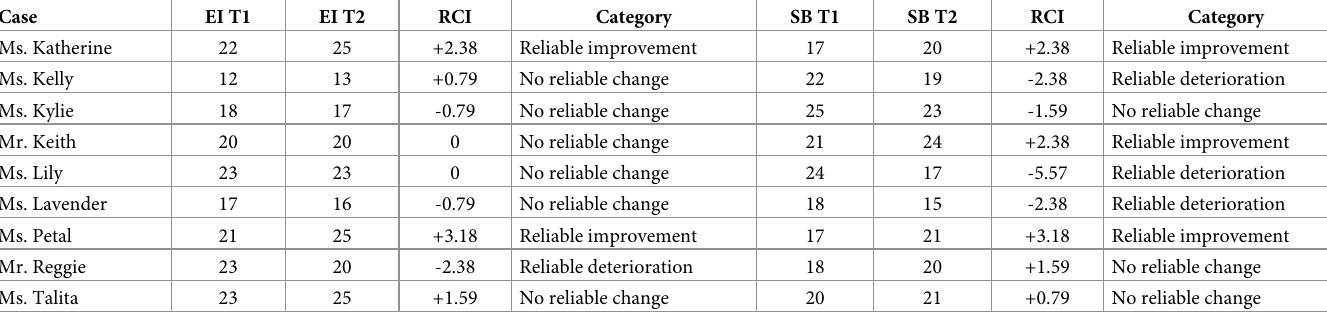
Table 4. RCI’s for Quality of Life Subscale Scores Empowerment Independence (EI) and Social Belonging (SB) ( N = 9). Case